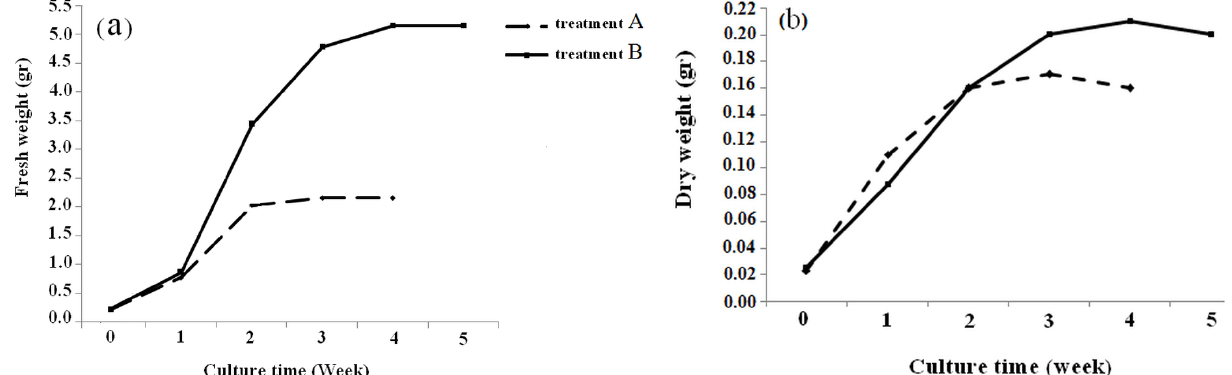
Fig. 3. Effect of different combinations of phytohormone on fresh (a) and dry (b) weight of cell from suspension cultures of Bunium persicum in a 5-week period in MS liquid medium. A (2 mg/l 2,4-D and 0.5 mg/l Kinetin ) and B (2 mg/l NAA and 0.5 mg/l